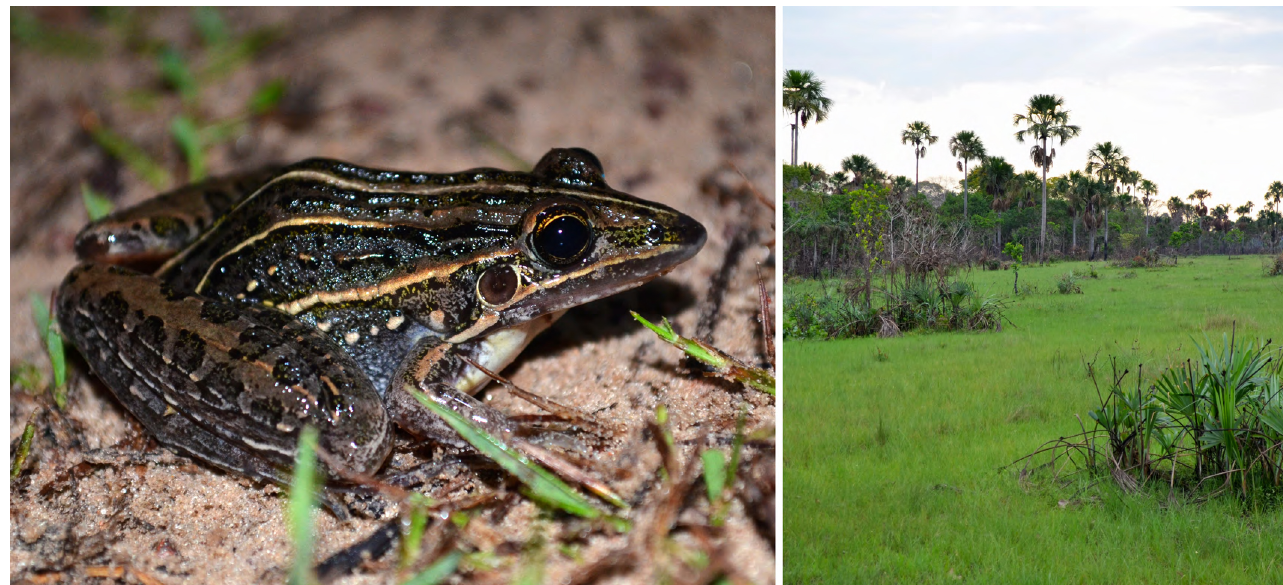
Figure 1. Left: An adult male of Leptodactylus sertanejo from Parque Estadual do Mirador, Maranhão, northeastern Brazil. Right: Habitat where the individual was